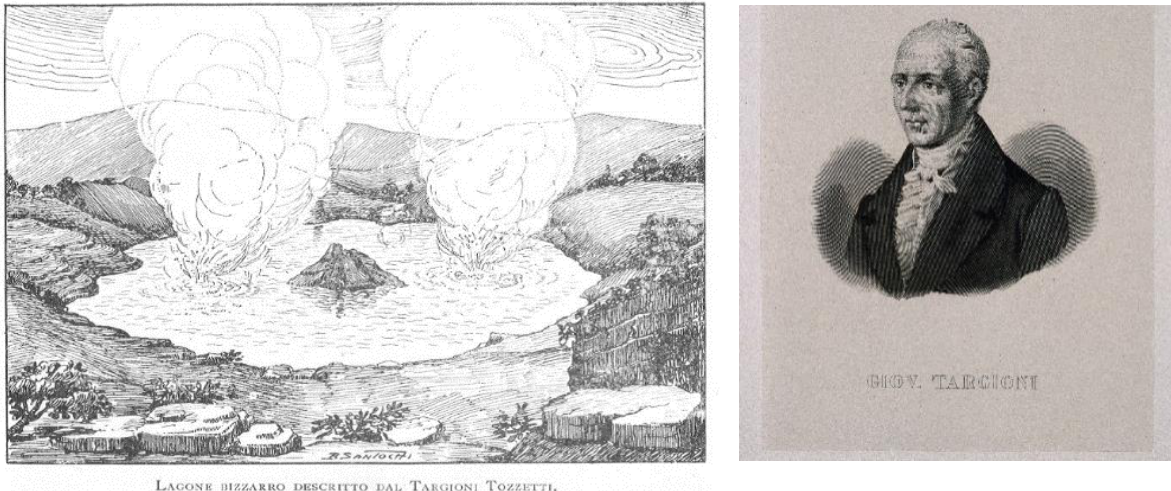
Figure 3. The first described ‘lagone’ called ‘lagone bizzarro’ (bizarre lake— left ) from Targioni Tozzetti and a picture of the author ( right ).